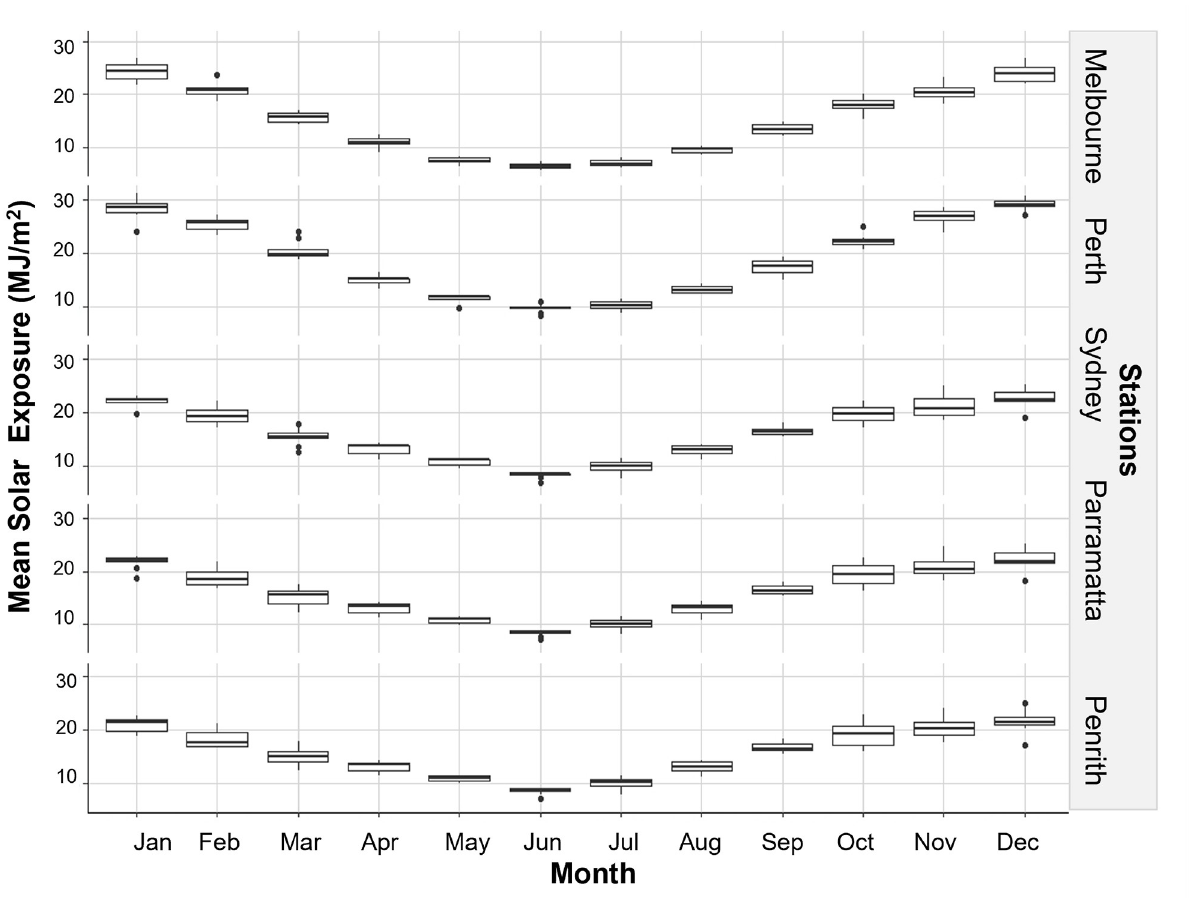
Fig 7. Trend in mean solar exposure between 2009–2019 at sampling